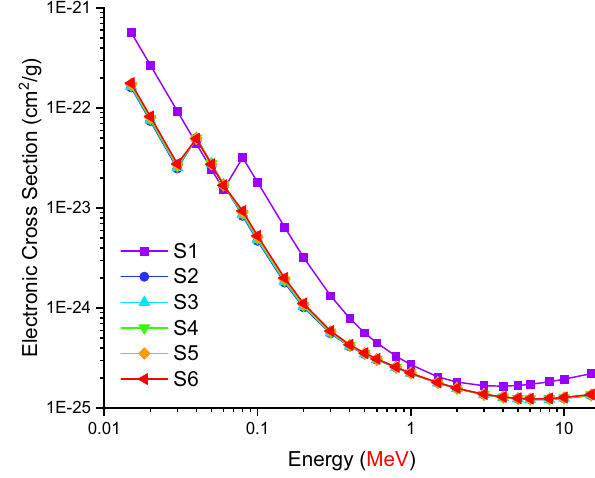
Figure 8: Variations of electronic cross - section with photon energy ( MeV ) for all S1 – S6